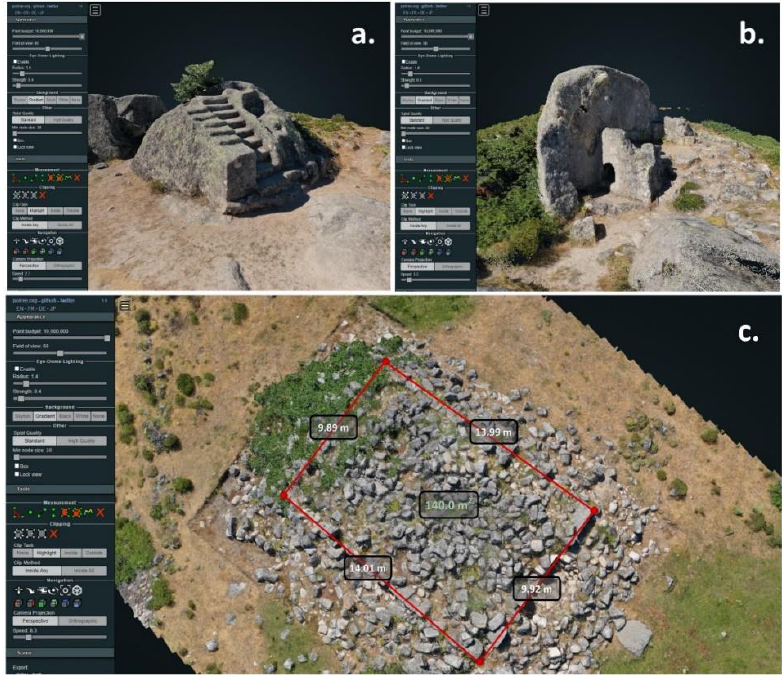
Figure 10. Different point clouds of the monuments of Ulaca oppidum : ( a ). Altar; ( b ). Sauna; ( c ). “ El Torreón ” , in which it is possible to observe the way of measuring and calculating volumes.